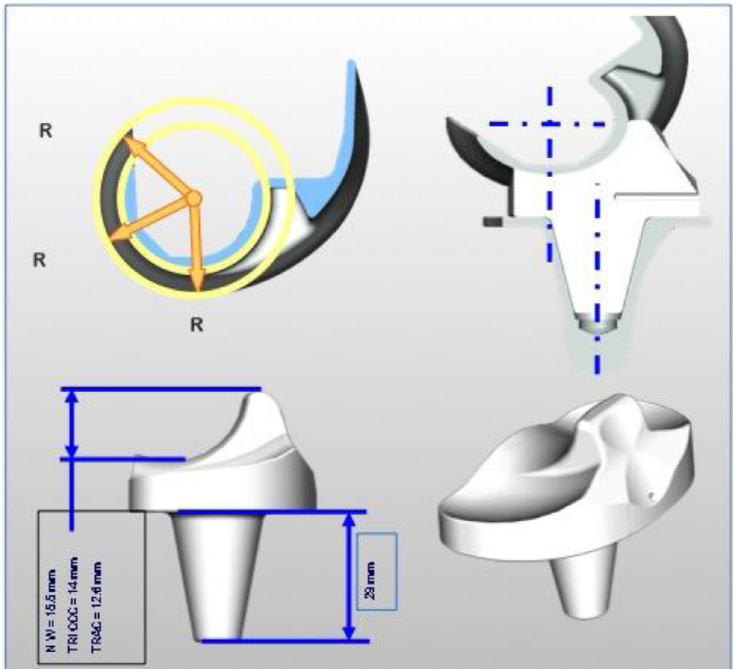
Figure 2. New Wave TKA TM implant features.